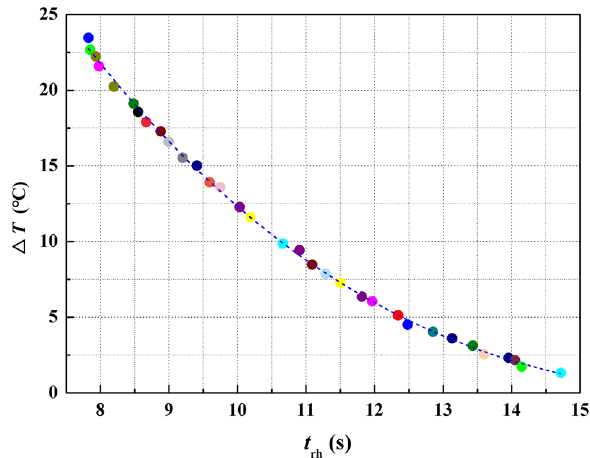
Fig. 6 Pareto solution set obtained by